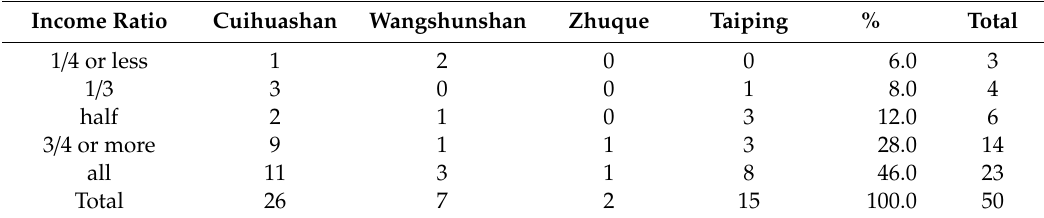
Table A6. Annual income / total household annual income ratio of respondents whose farmland was requisitioned for the geopark ( n =